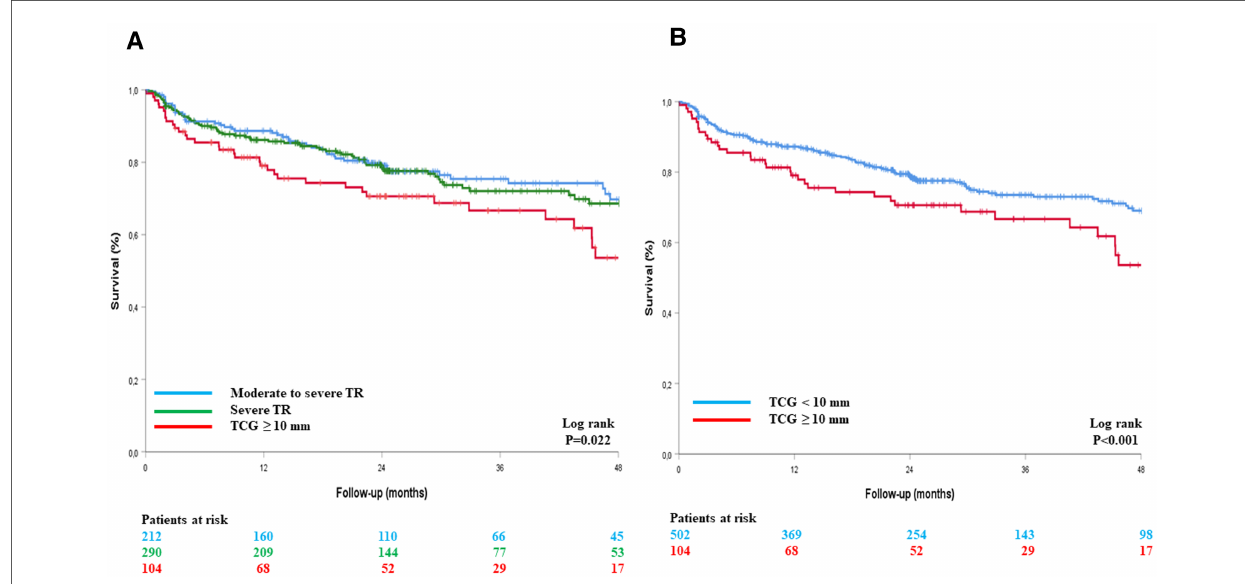
FIGURE 3 Kaplan – Meier survival curves of patients with TR, with VSTR de fi ned by TCG ≥ 10 mm, in three groups ( A ) and in two groups ( B ). TCG, tricuspid coaptation gap; TR, tricuspid